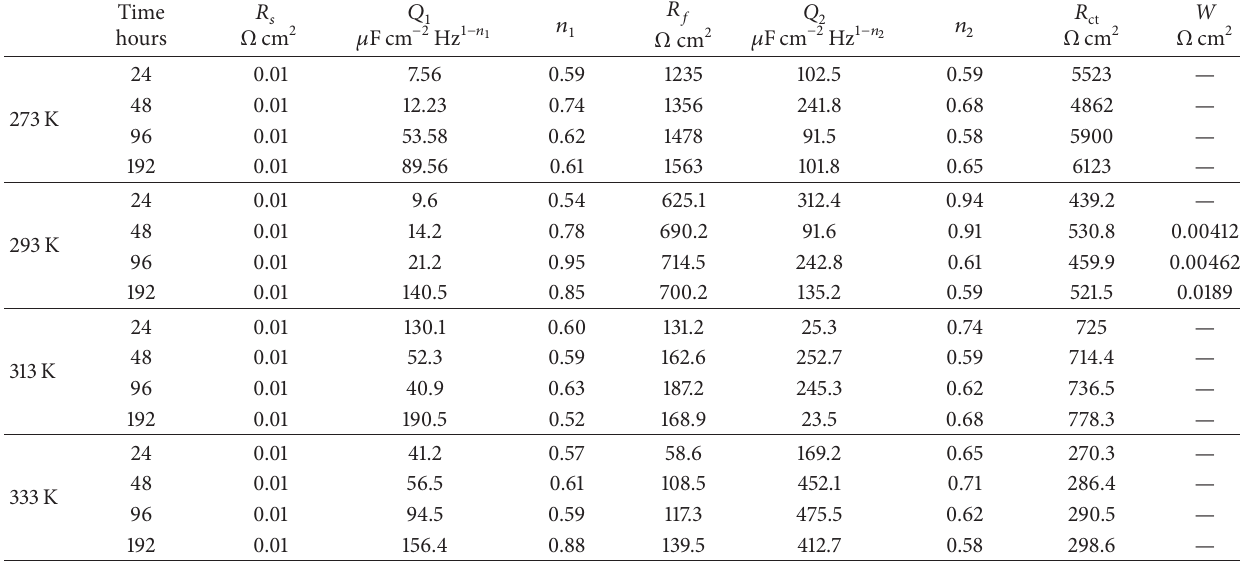
Table 2: EIS fitting parameters of galvanized steel after various immersion times in CRL solution at 0.1MPa under different temperatures (273, 293, 313, and 333